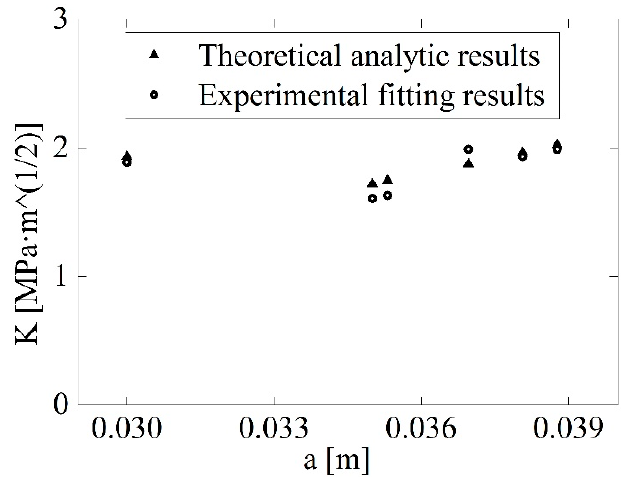
Figure 3. Comparison between theoretical SIF results and experimental SIF results. The theoretical SIFs are derived using Equation (9). The experimental SIFs are derived using a combined method of Digital Image Correlation (DIC) full-field displacement extraction and the fitting of Williams’ series. The specimens are loaded to the SIF that is slightly lower than the fracture toughness.